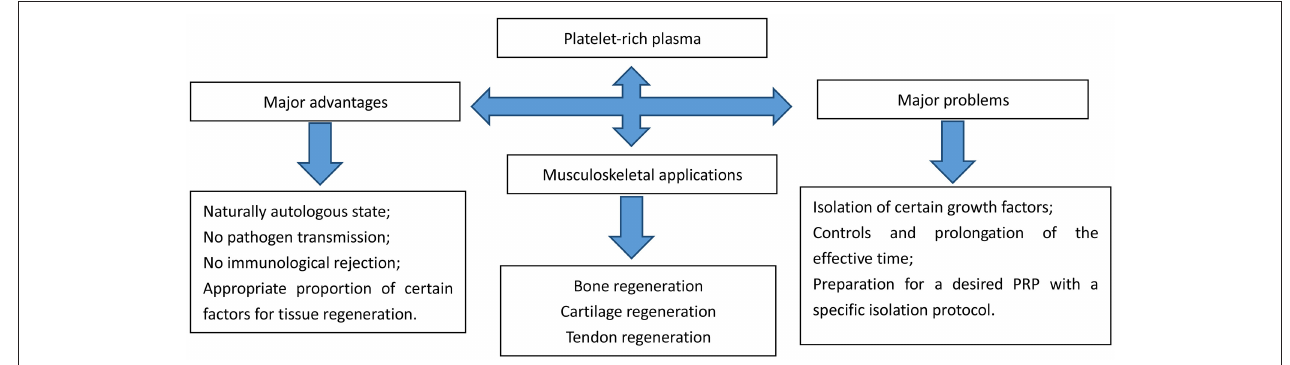
FIGURE 1 | Advantages, applications, and problems of platelet-rich